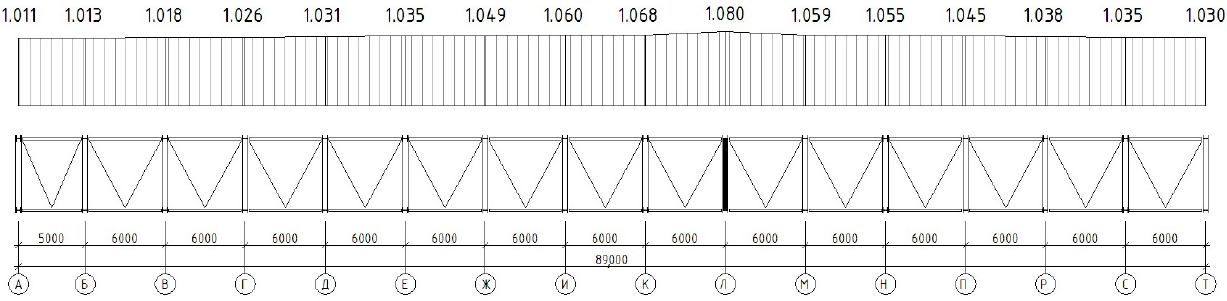
Figure 26. Diagram of the distribution of the dynamic coefficient in case of damage to the lower chord.